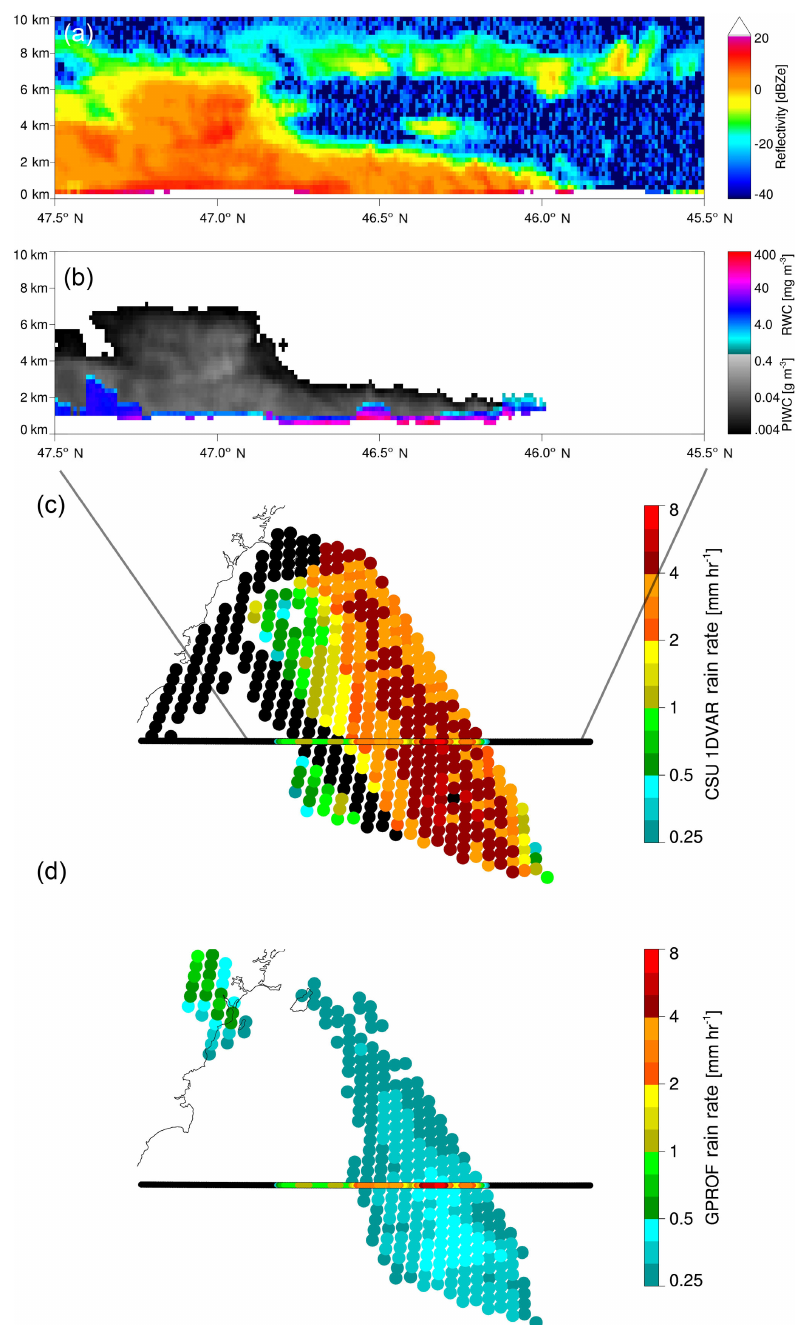
Figure 8. Shallow rain and mixed phase cloud off the coast of France, 30 March 2016. The panel (a) is CloudSat reflectivities while panel (b) shows 2C-Rain-Profile RWC and PIWC profile retrievals from the same scene. The panels (c) and (d) contrast CloudSat rain rates with those of the CSU 1DVAR and GPROF. Colour conventions follow those of Fig.